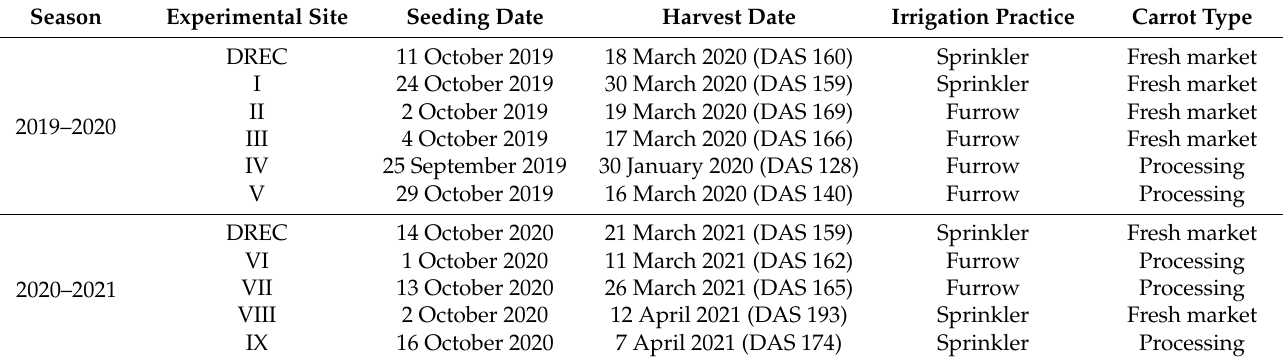
Table 3. General information for the experimental sites. Plant establishment was performed using sprinkler irrigation at all sites.